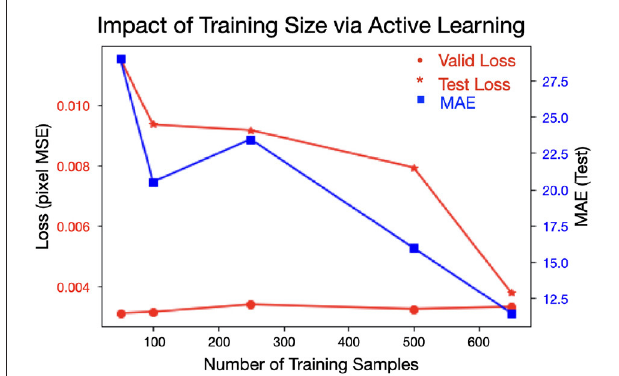
FIGURE 8 | Increasing the amount of (labeled) training data in a smart fashion decreases test loss as well as the MAE on the test set. The validation loss slightly increases as more data is added, suggesting less over-fitting is occurring as more data is